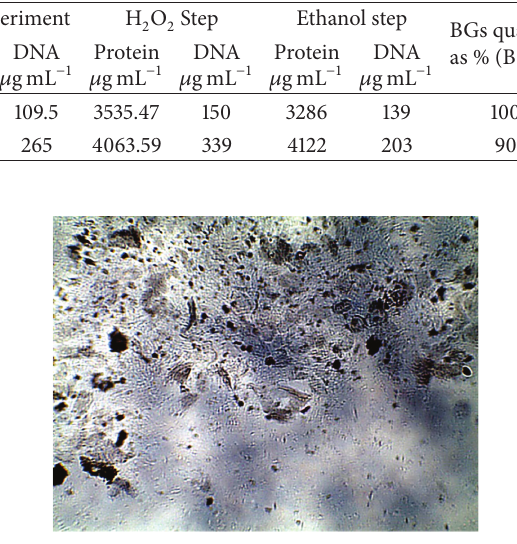
Figure 3: Agglutination reaction of BGs prepared from S.